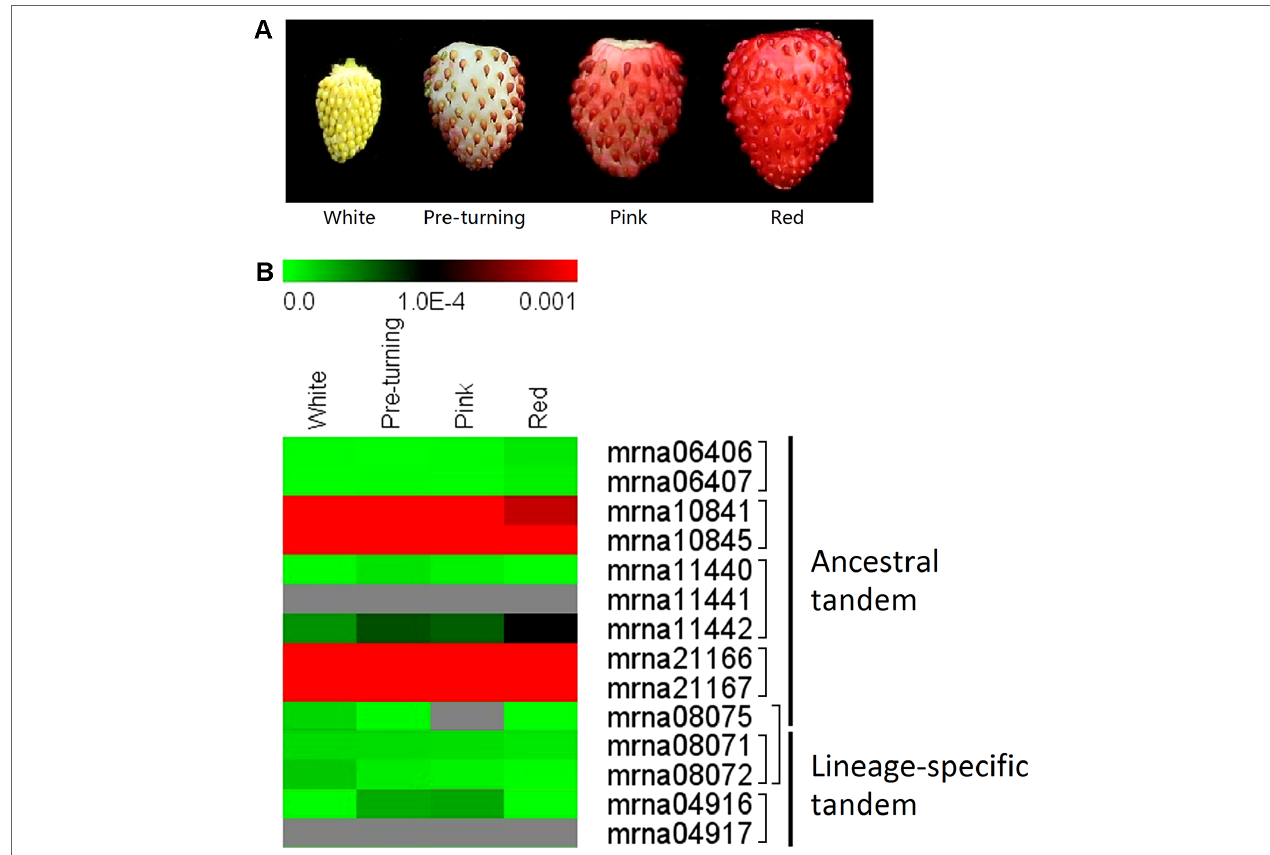
FIGURE 5 | Expression profiles of tandem FveERF genes during fruit ripening. (A) The schematic diagram for the four stages of fleshy fruits investigated in B. (B) The expression levels of tandem FveERF genes relative to GAPDH , measured by quantitative RT-PCR and displayed in the log2 scale. Genes located in the same tandem repeat are grouped together. Mrna08075 forms an ancestral tandem repeat with mrna08071 and mrna08072. Three biological replicates and three technical replicates were obtained for each data